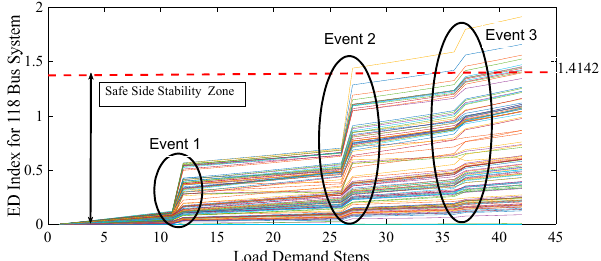
Figure 21. The response of the ED index for the case including three events related to the load demand steps for the IEEE 118-bus test system.